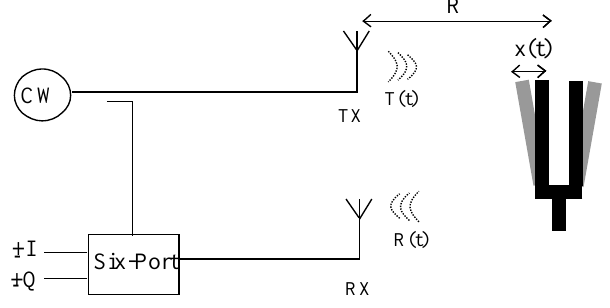
Figure 1. Simplified block diagram of the CW Doppler